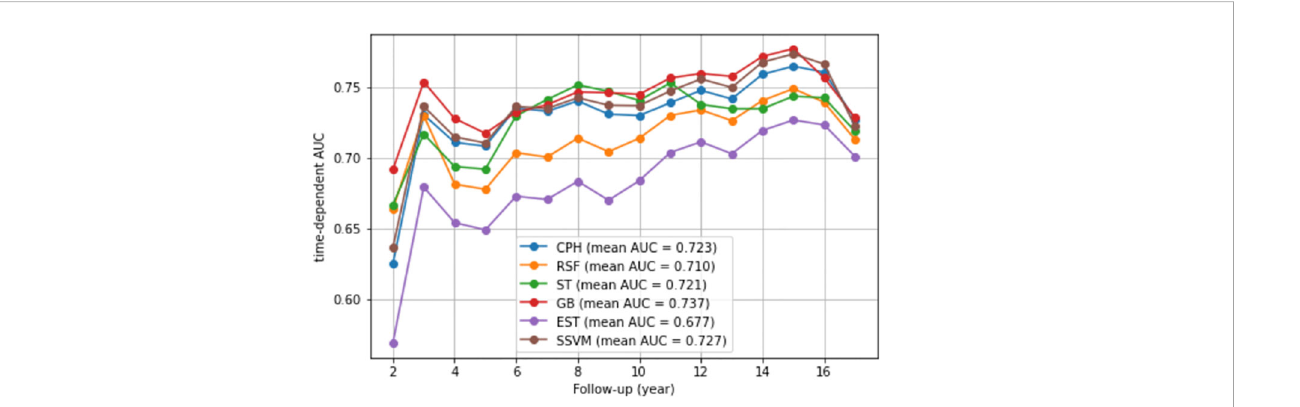
FIGURE 2 Time-dependent AUC. We presented the time-dependent AUC of the CPH model and fi ve ML models, namely, the random survival forest, survival trees, gradient boosting, extra survival trees, and survival support vector machine models. The vertical axis is the time-dependent AUC. The horizontal axis is follow-up (year).